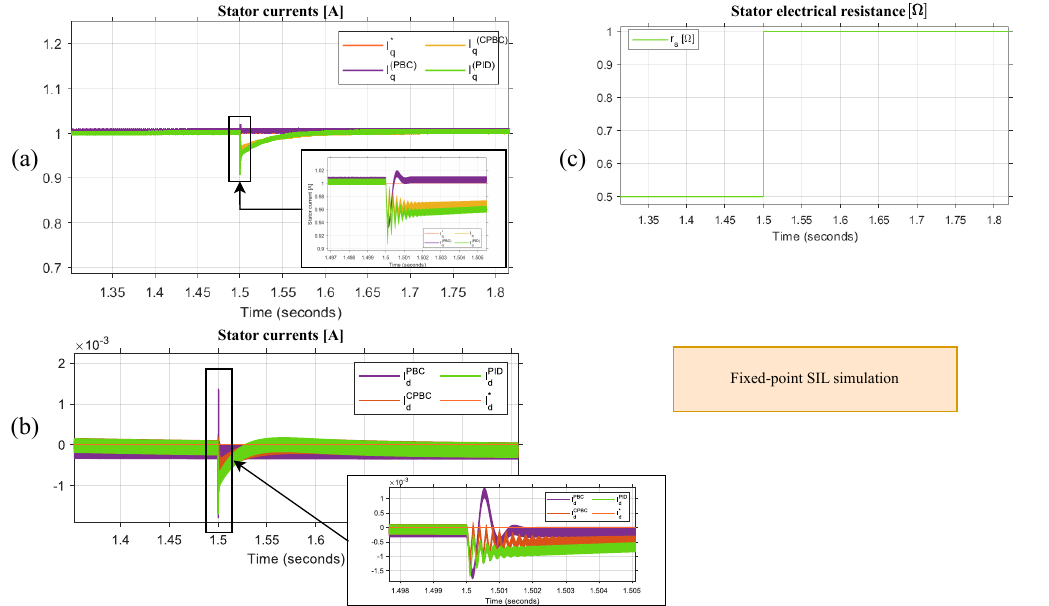
Figure 16. Comparison of software-in-the-loop simulation of currents controller under variation of phase resistance (conventional PBC, PBC, PID): ( a ) quadrature current [A]; ( b ) direct axis current [A]; ( c ) stator electrical resistance [ Ω